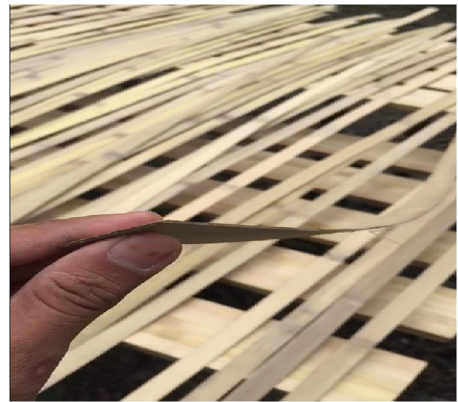
Figure 2: Apus bamboo